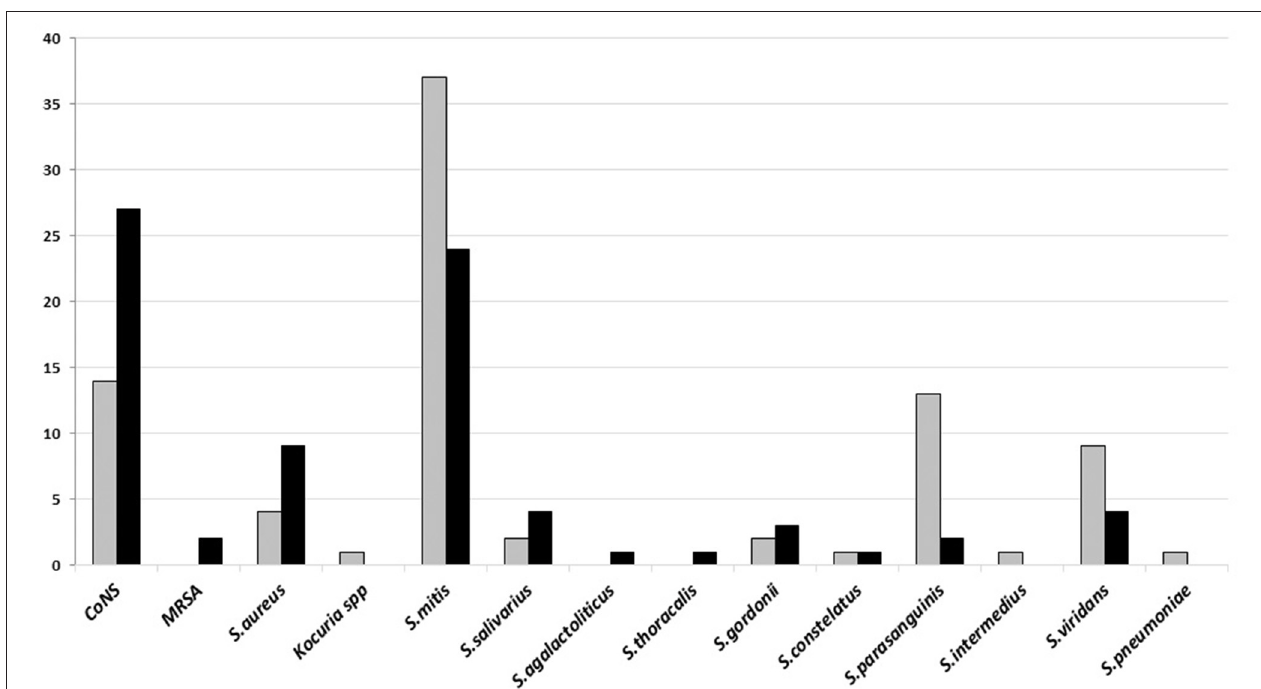
FIGURE 2 | The number of Gram-positive bacteria isolated on sputum culture from January to June 2018 in Tertiary Sanglah Referral Hospital in Bali, Indonesia. Gray and filled boxes are poor and good-quality sputum, respectively.